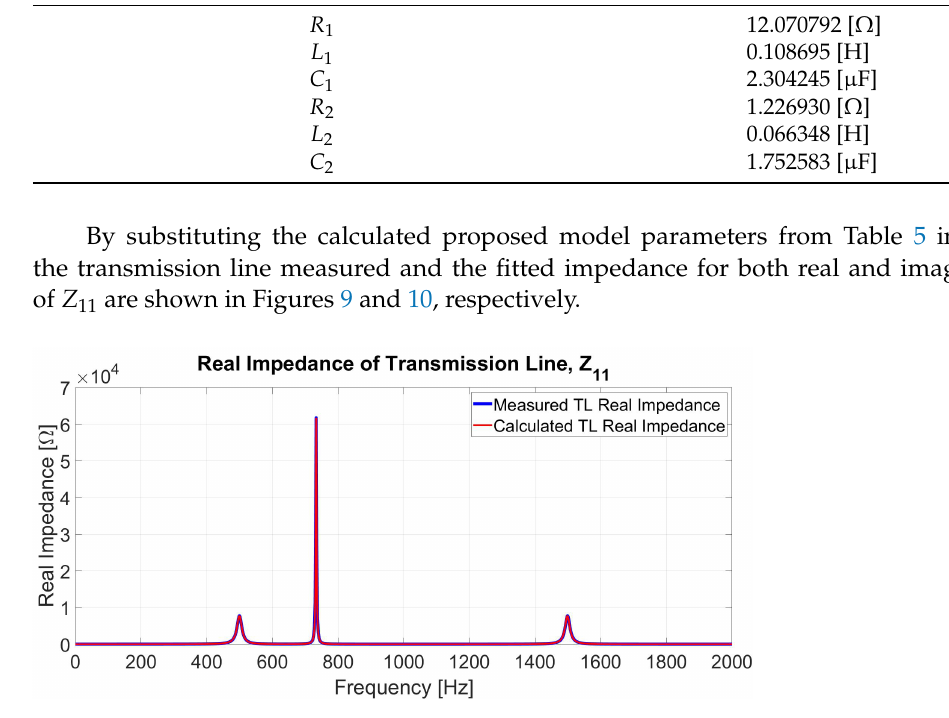
Figure 9. Frequency response measurements and the proposed model calculation of transmission line real impedance ( Z 11 ).